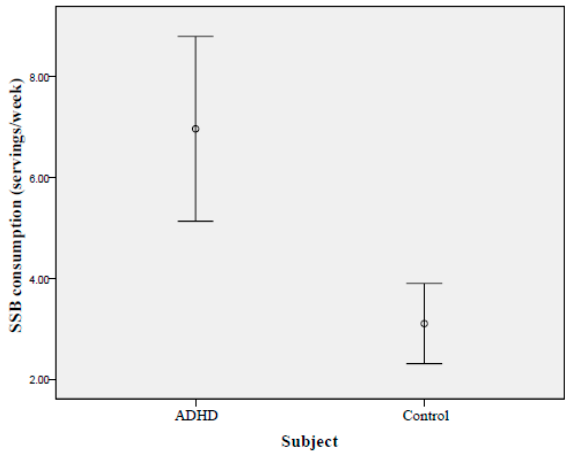
Figure 1. Mean consumption (95% CIs) of SSBs among controls and children with ADHD (unit = servings/week).